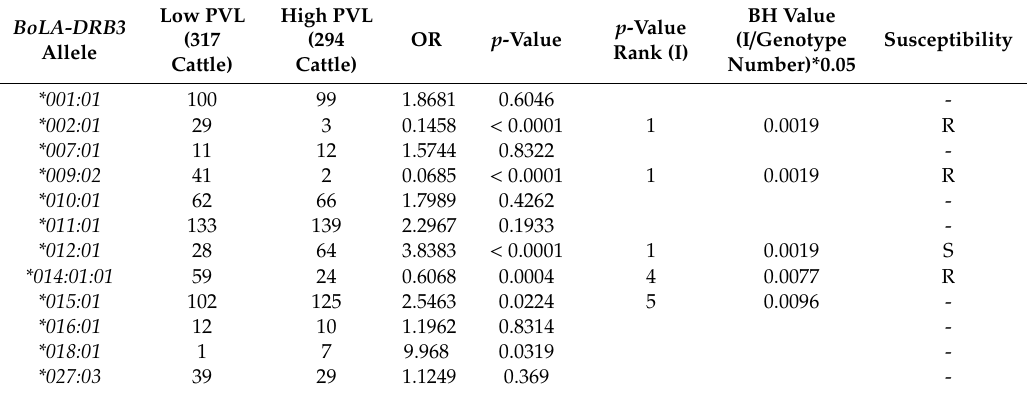
Table 5. Fisher’s exact test based association analysis of BoLA-DRB3 alleles in low PVL and high PVL cows.